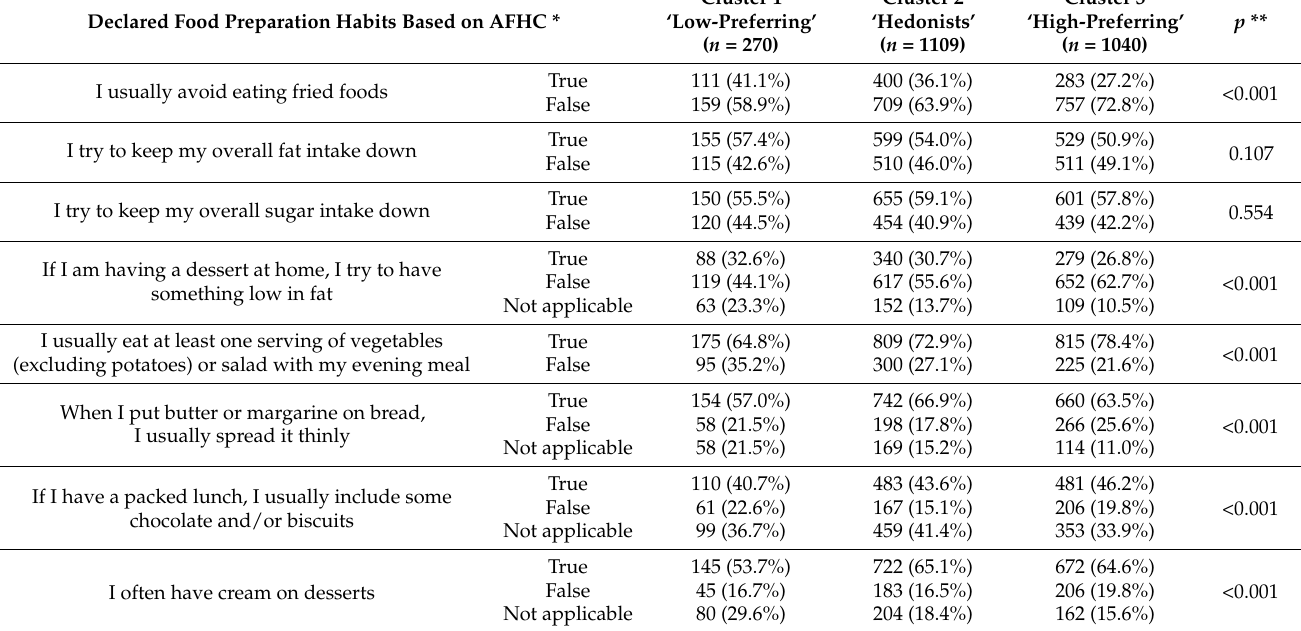
Table 4. The declared food preparation habits assessed based on the Adolescents’ Food Habits Checklist (AFHC) in the clusters stratified based on the preferences assessed while using the Food Preference Questionnaire (FPQ) within the population of the second phase of the Polish Adolescents’ COVID-19 Experience (PLACE-19) Study ( n =